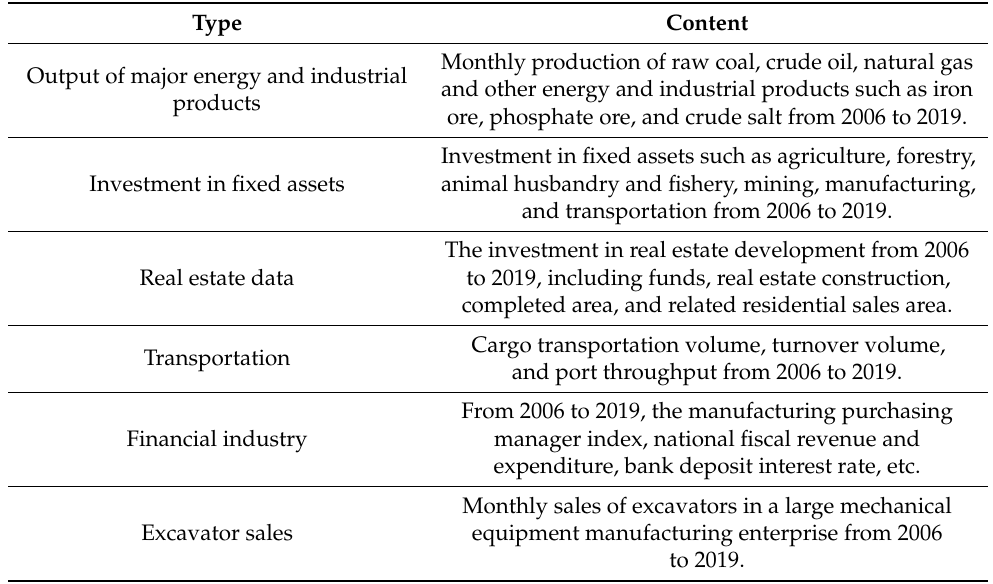
Table 1. The key factor indicators of excavator